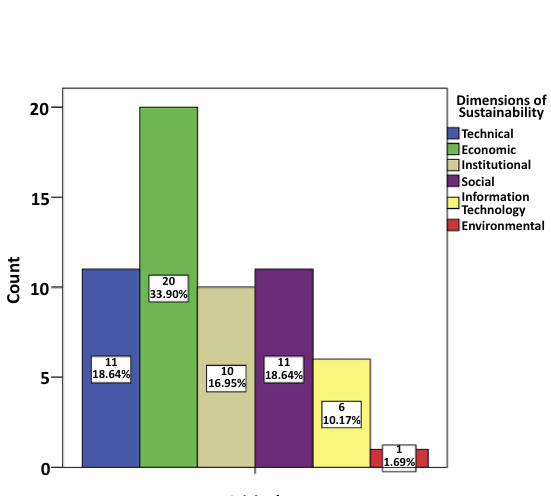
Figure 4. Distribution of supply chain sustainability risks